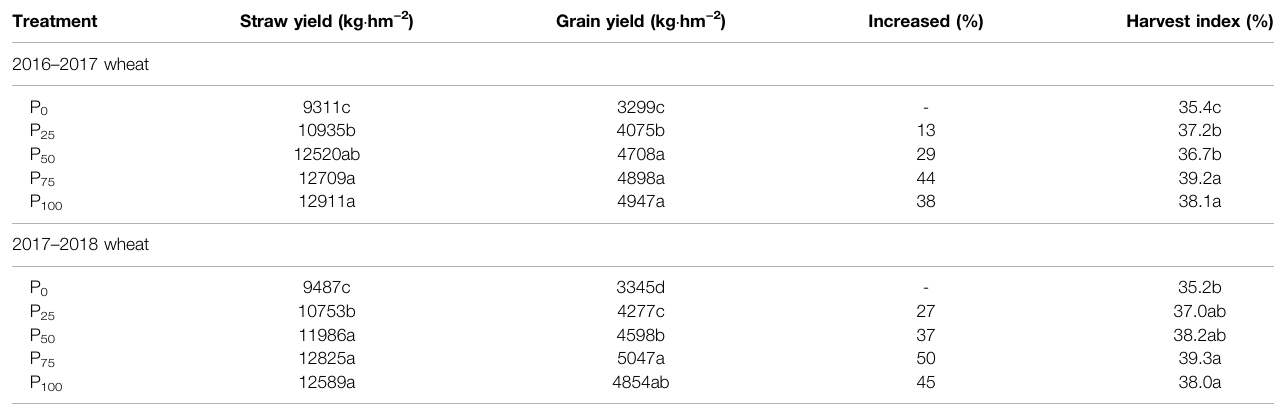
TABLE 3 | Effect of P fertilization rates on wheat yield. Treatment